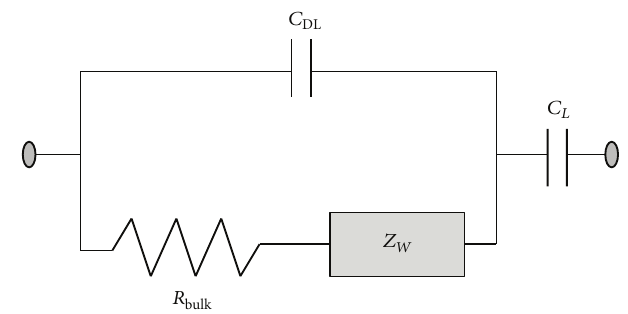
Figure 15: Proposed scheme of equivalent circuit for CS NiO 𝑥 polarized at 3.55 V versus Li +